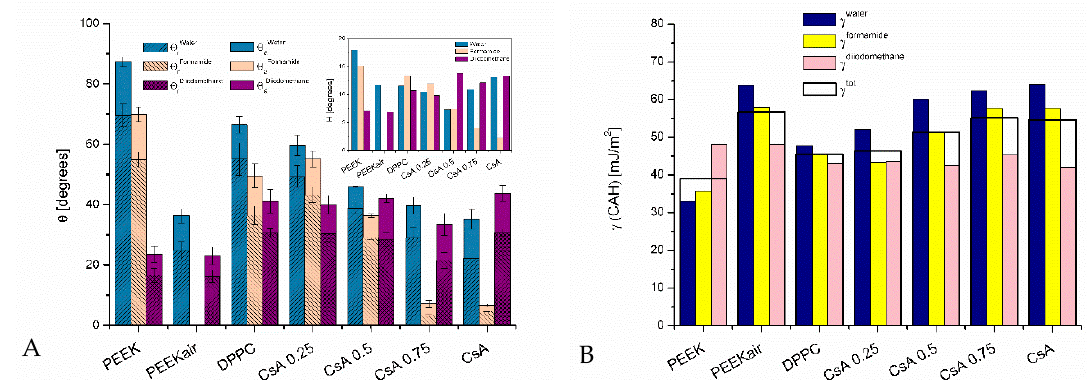
Figure 4. ( A )—Advancing and receding contact angles of water, formamide, and diiodomethane and their hysteresis (H); ( B )—Surface free energy ( γ s ) estimated from the contact angle hysteresis of water, formamide, and diiodomethane and their arithmetic mean ( γ tot s ) for the modified PEEK surfaces.